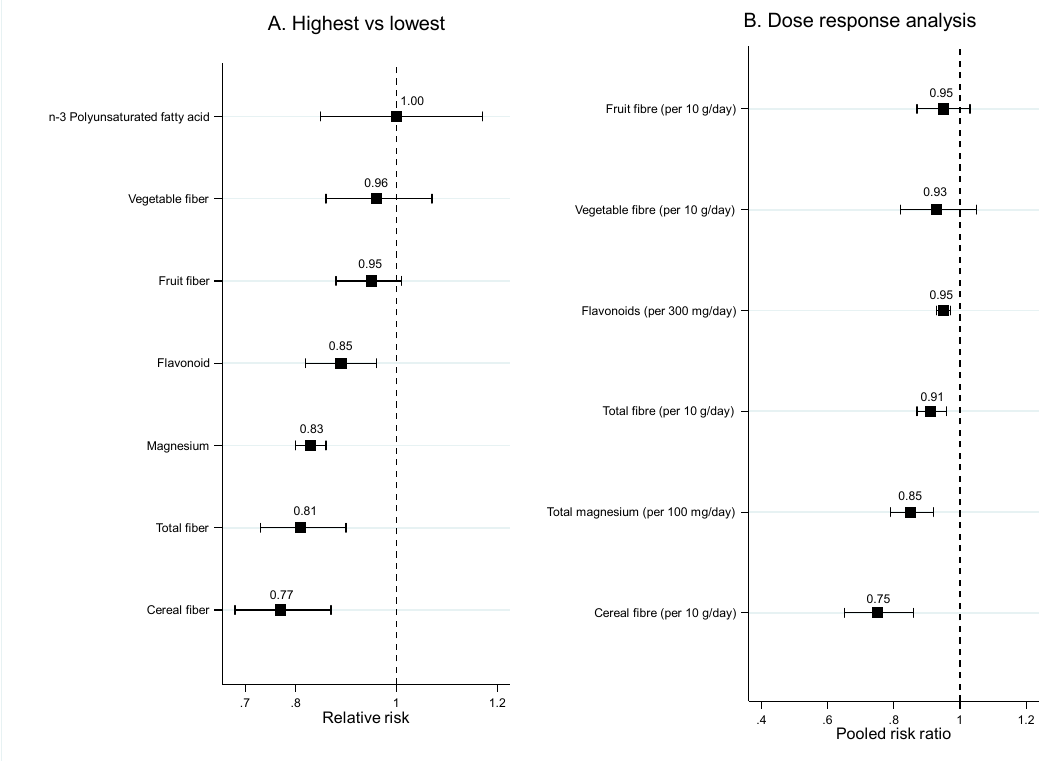
Figure 3. Pooled risk ratios of food nutrients and risk of T2DM. ( A ) Highest versus lowest category comparison. ( B ) Dose response analysis.